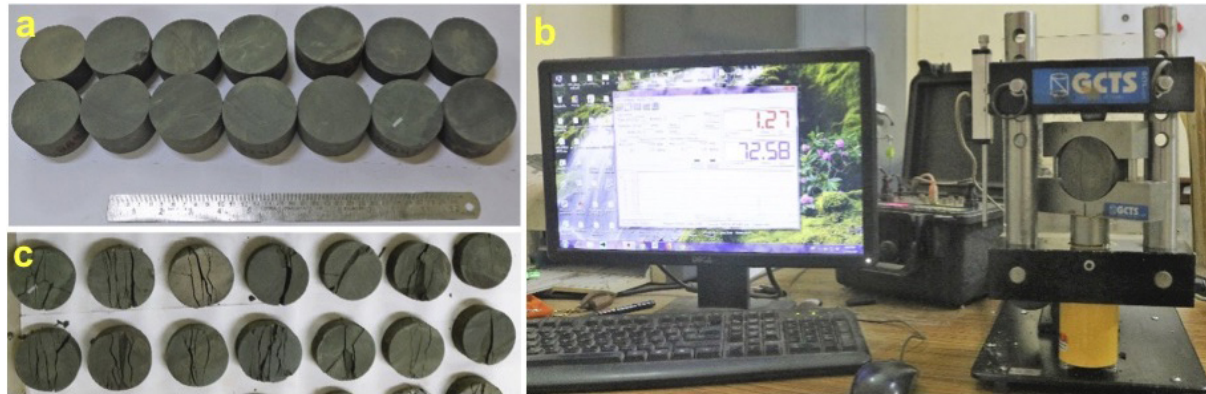
Figure 6. Tensile strength determination of metabasalt samples. (a) Sample cores for Brazilian tensile strength (BTS) determination. Diameter : length = 2 : 1. (b) Instruments used for measuring BTS. (c) Sample cores obtained after